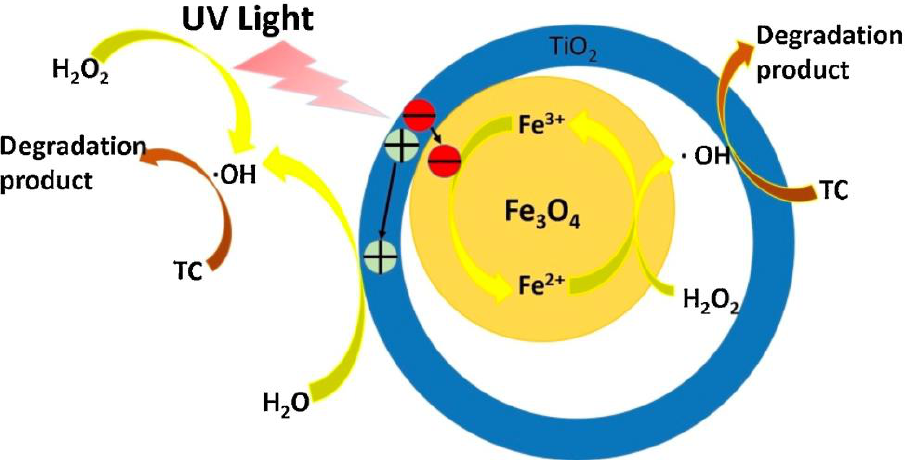
Figure 9. The photo-Fenton-like degradation mechanism for tetracycline [76]. The magnetically separable graphene oxide supported titanium dioxide integrated ferro-ferric oxide (Fe 3 O 4 /rGO/TiO 2 ) hybrid photocatalyst enhanced the photocatalytic activity towards the degradation of tetracycline hydrochloride (~92.6%) under visible light irradiation. The enriched catalytic activity was achieved by the synergistic effect of photo-Fenton reaction and the higher charge transportation and conducting ability of graphene. Furthermore, the catalyst system is found to be with high reusability